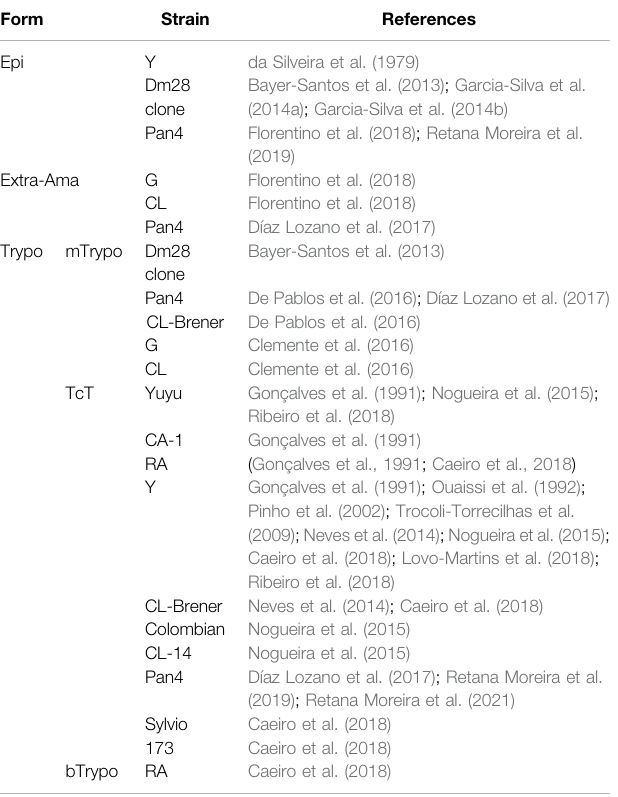
TABLE 1 | Extracellular vesicles shed by various strains and forms of T.